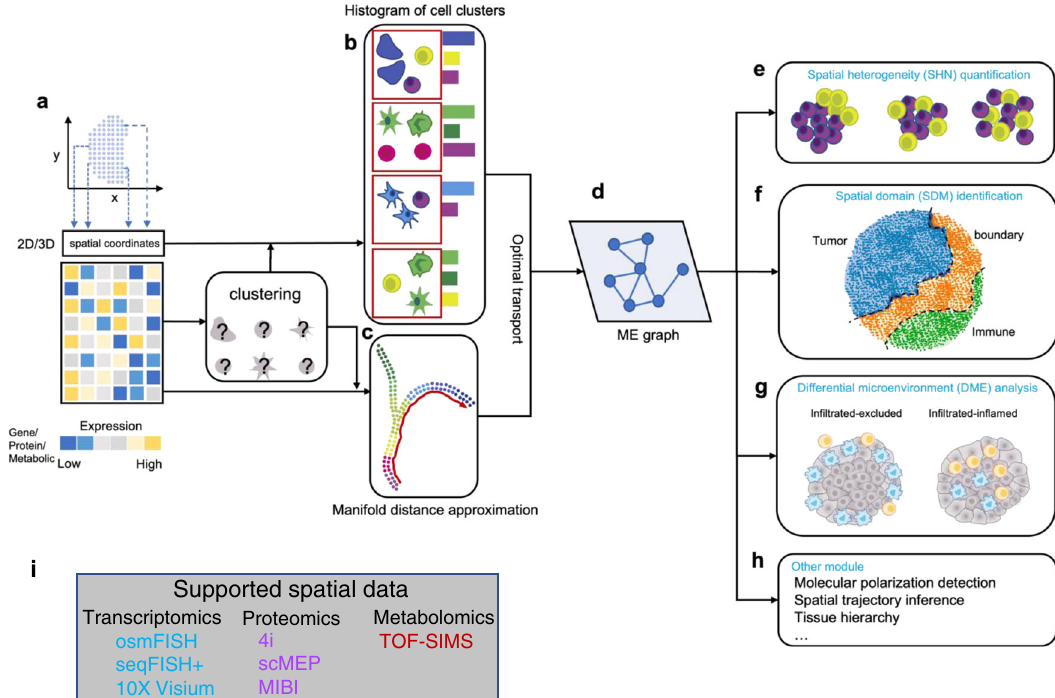
Fig. 1 | Schematic overview. a – h Overview of SOTIP. SOTIP takes 2D/3D spatial omics data (spatially resolved gene expression, protein or metabolic pro fi les) as input ( a ). Next, the cell (spot) type clustering is obtained solely by the expression matrix. Then the histogram of cell clusters is obtained combing the spatial infor- mation and clustering result ( b ). The manifold distance is approximated by combingclusteringresultandtheexpressionmatrix( c ).TheMEgraphisbuiltusing